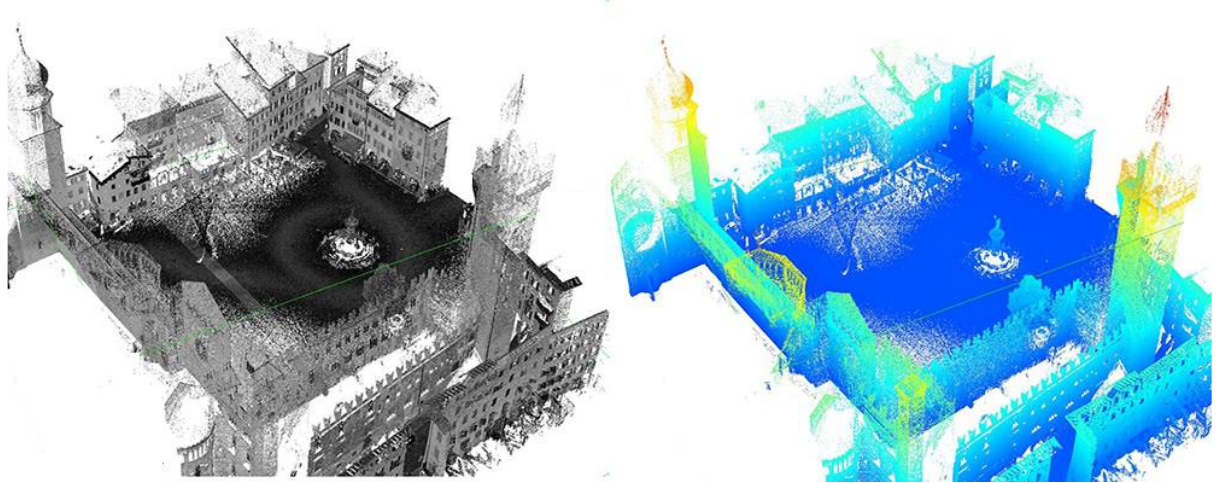
Figure 14. Intensity (left) and elevation (right) map of the MMS data collected in the Duomo square of Trento